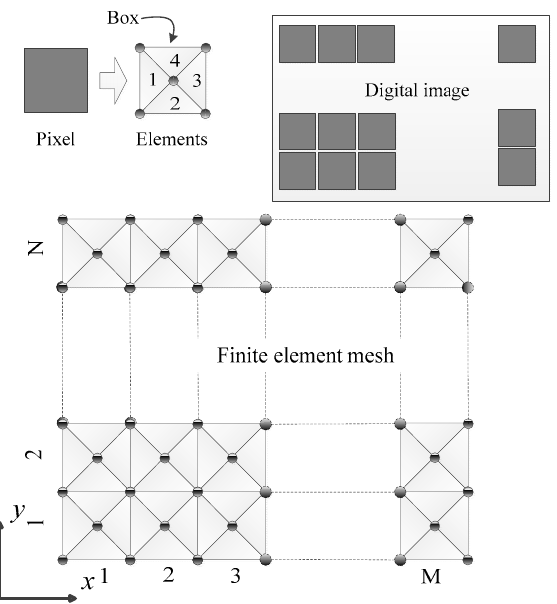
Figure 2. Schematic of the one-to-four mapping method.